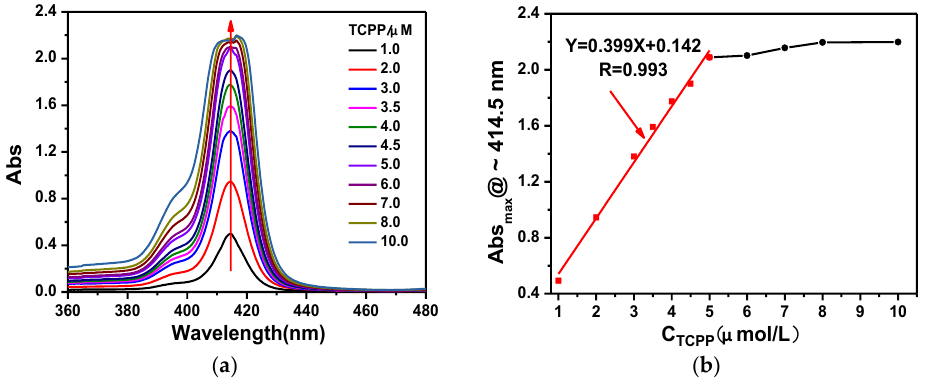
Figure 1. ( a ) UV-vis absorption spectra and ( b ) maximum absorption at ~414.5 nm of TCPP solutions at various concentrations. Red line fits the Lambert–Beer Law, R = 0.993. Black line deviates from Beer’s law.